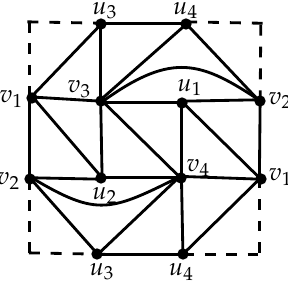
( b ). An N -embedding of H 2